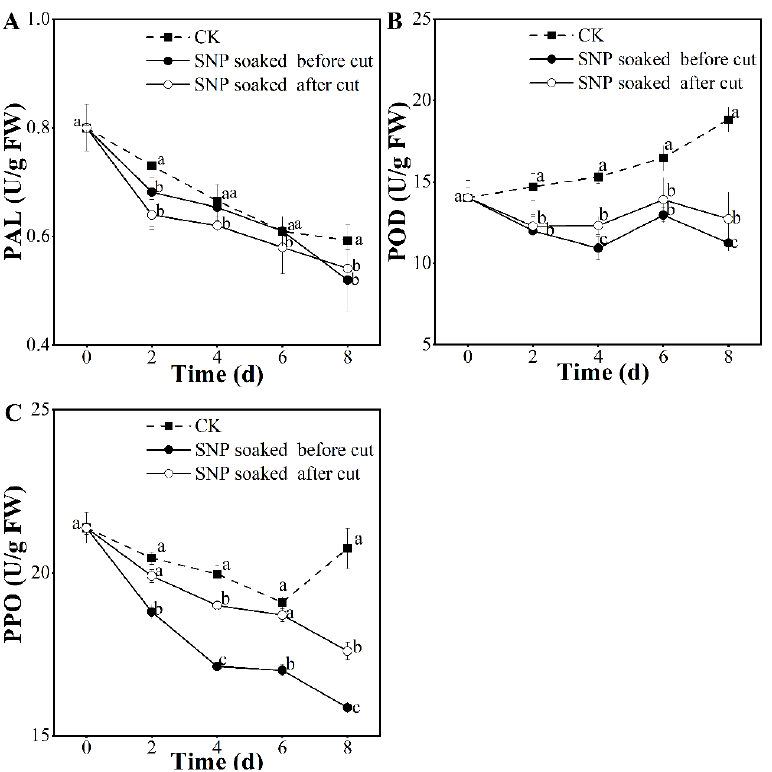
Figure 6. Effect of SNP treatment on enzyme activities PAL ( A ), POD ( B ), and PPO ( C ) of fresh-cut potatoes. Different letters indicate significant differences among treatments at same storage time ( p < 0.05).